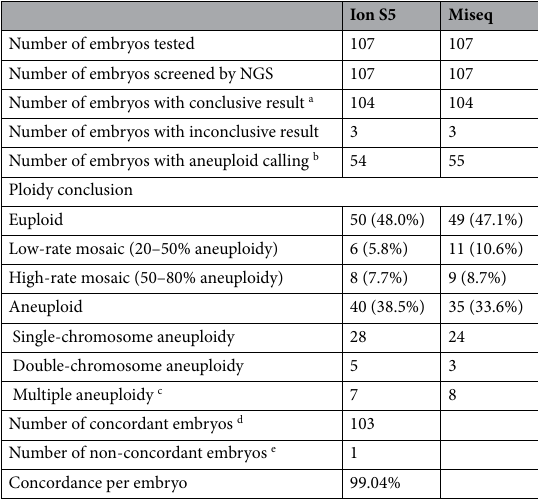
algorithm. Of the measure of background noise in individual samples, the Ion Reporter displayed the median of the absolute values of all pairwise differences (MAPD), while the BlueFuse Multi reviewed the derivative log 2 ratio (DLR) for the spread of the difference in CNV between all bins within a chromosome (Detection of aneuploidy in a single cell using the Ion ReproSeq PGS View Kit, Application Note, Thermo Fisher Scientific; BlueFuse Multi v4.5, Software Guide, Illumina). Common calling criteria were applied in the parallel comparison of this study, and it was determined by the former four cell line models. Eventually, high concordance in the clinical samples was obtained between the automatic and manual identifications. However, some differences still existed between the two approaches though common criteria were used. First, the Ion Reporter provided a tunable analysis workflow followed with an automatic identification under this frame, and the BlueFuse Multi allowed operators to make manual calling based upon its own default settings, which are unchangeable (Ion Reporter™ 5.10 User Guide, Thermo Scientific Fisher; BlueFuse Multi v4.5, Software Guide, Illumina). Therefore, some parameters were unable to be completely synchronized between the two software, such as the transition penalty, which represents the sensitivity of different ploidy status between two adjacent data points. Second, manual intervention is not required during automatic identification of the Ion Reporter, while it is necessary for the BlueFuse Multi when the technician observes a